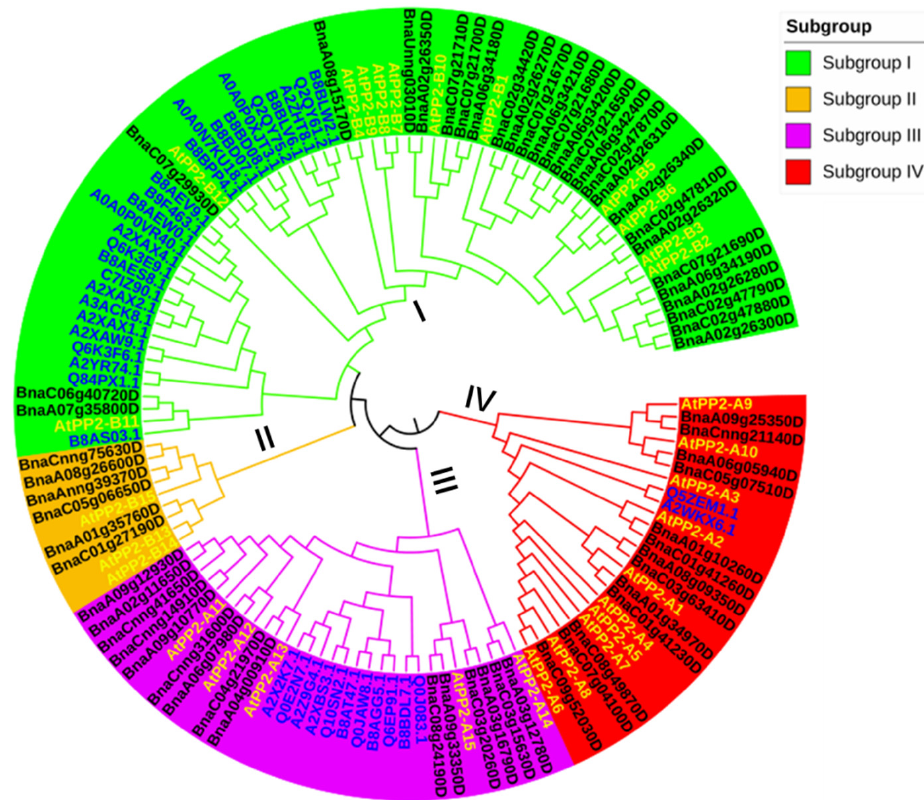
Figure 1. The phylogenetic analysis of PP2 proteins in A. thaliana , O. sativa and B. napus. All PP2 proteins were clustered into four subfamilies (I–IV) with differently colored branches (I, green; II, orange; III, purple; IV, red). The gene IDs for B. napus are black, the gene IDs for A. thaliana are bright yellow and those for O. sativa are blue.